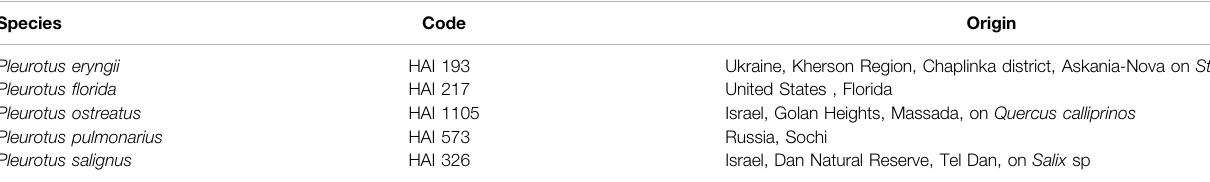
TABLE 1 | Studied Pleurotus